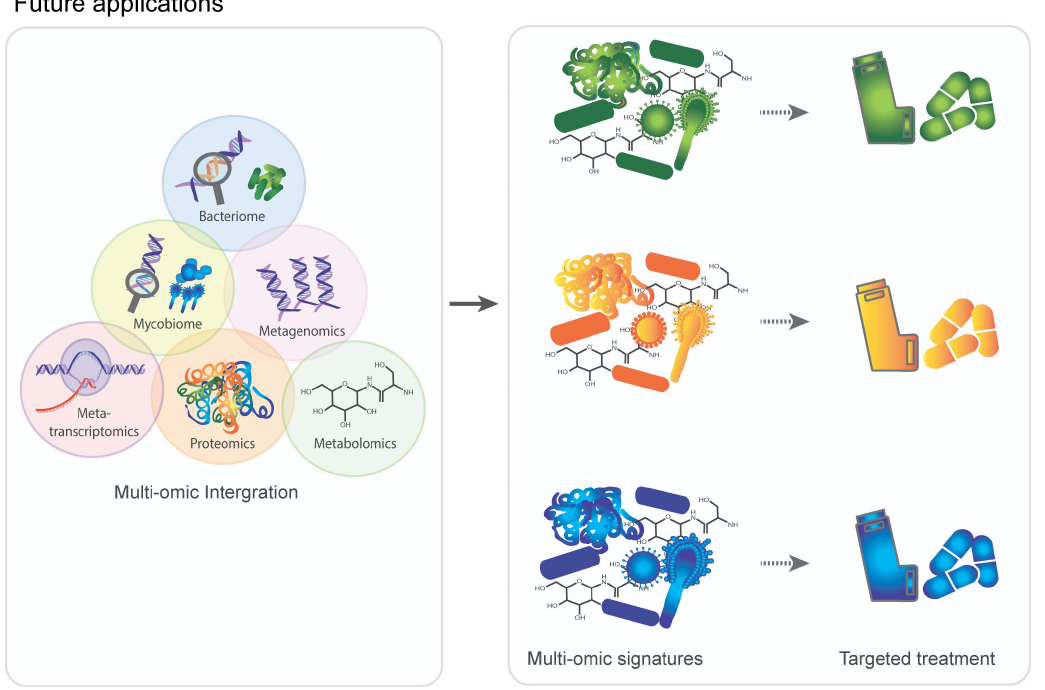
Figure 2. Future applications of integrative multi-omic approaches in COPD will lead to individualized multi-omic signatures with the potential for personalized COPD treatment.